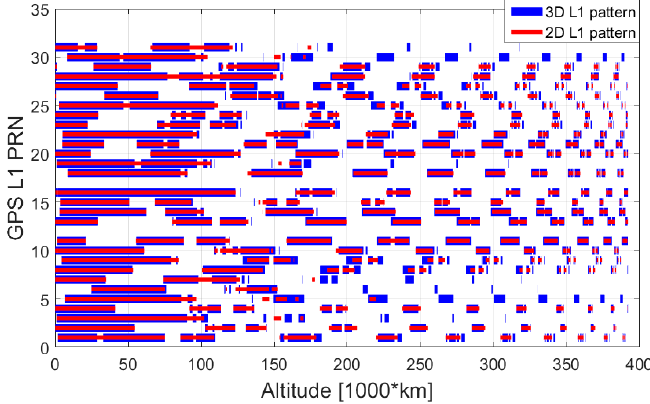
Figure 10. Available GPS L1 signals, during the assumed MTO, for a 10 dBi receiver gain pattern.